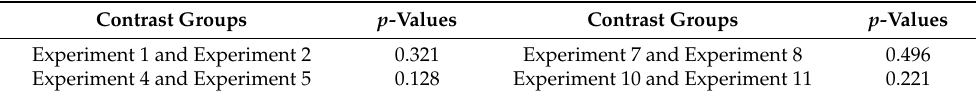
Table 6. Mann–Whitney U test of the effects of information feedback on